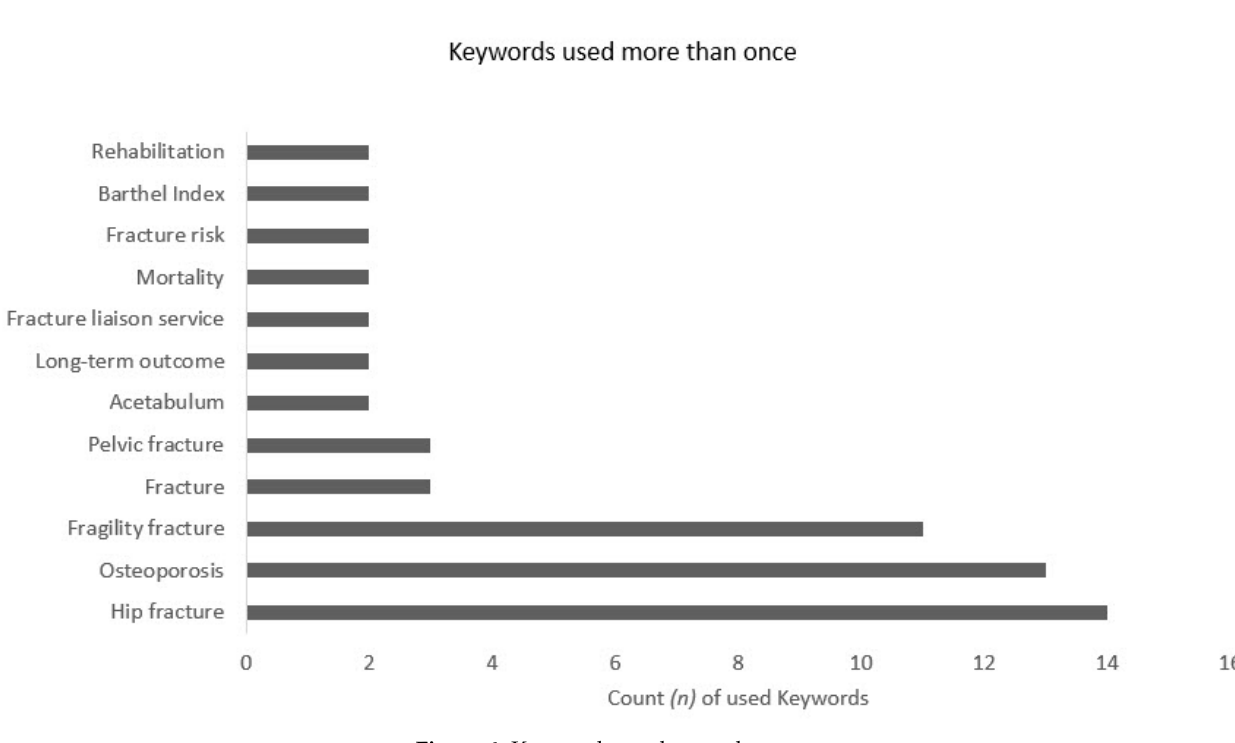
Figure 6. Keywords used more than once.